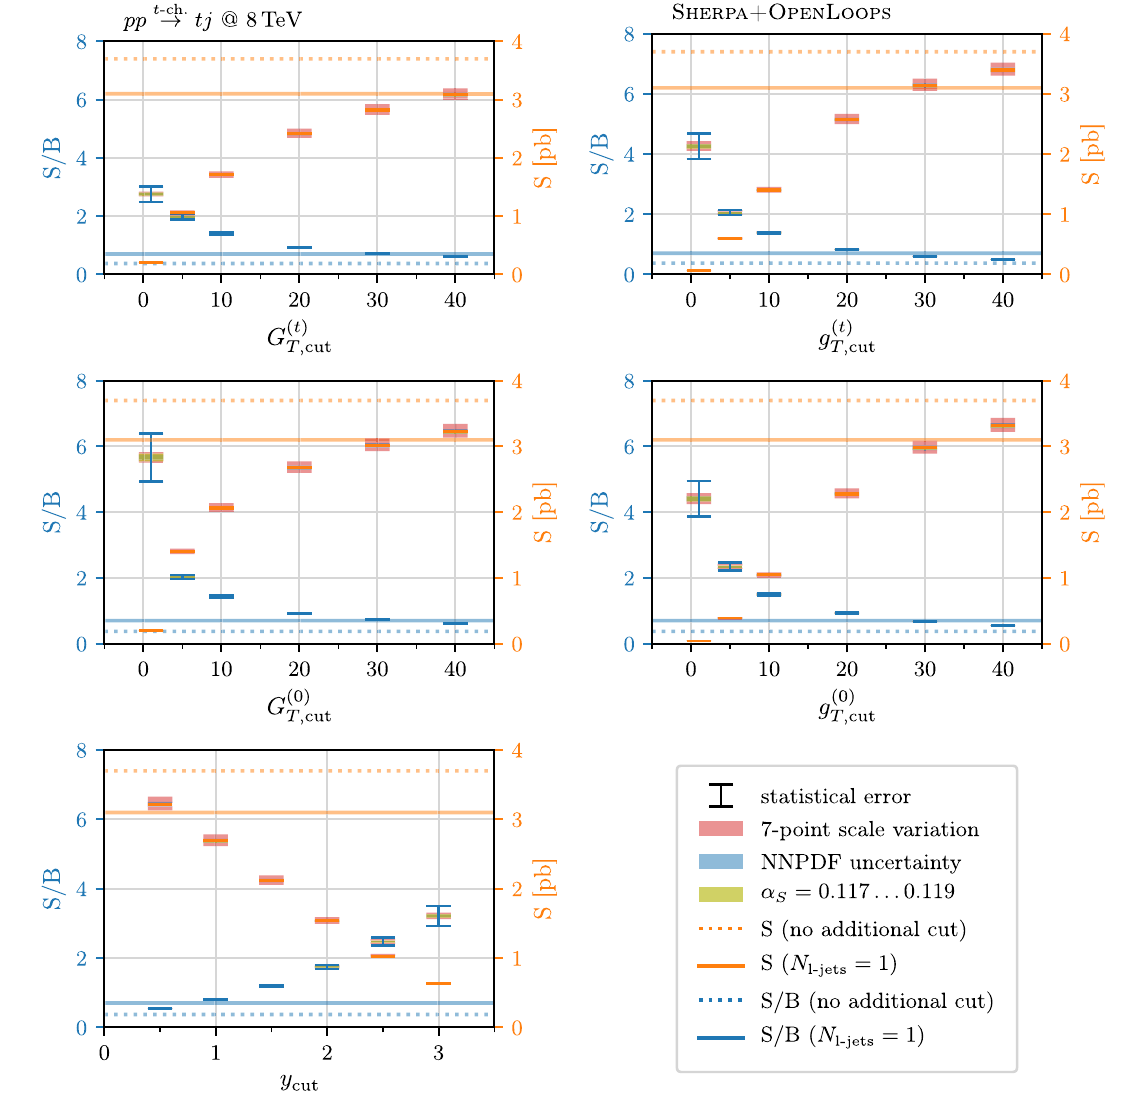
and α s uncertainties are varied consistently for all calculations. The large statistical uncertainties visible for the highest S / B values origi- nate in the considerable background suppression using the respective